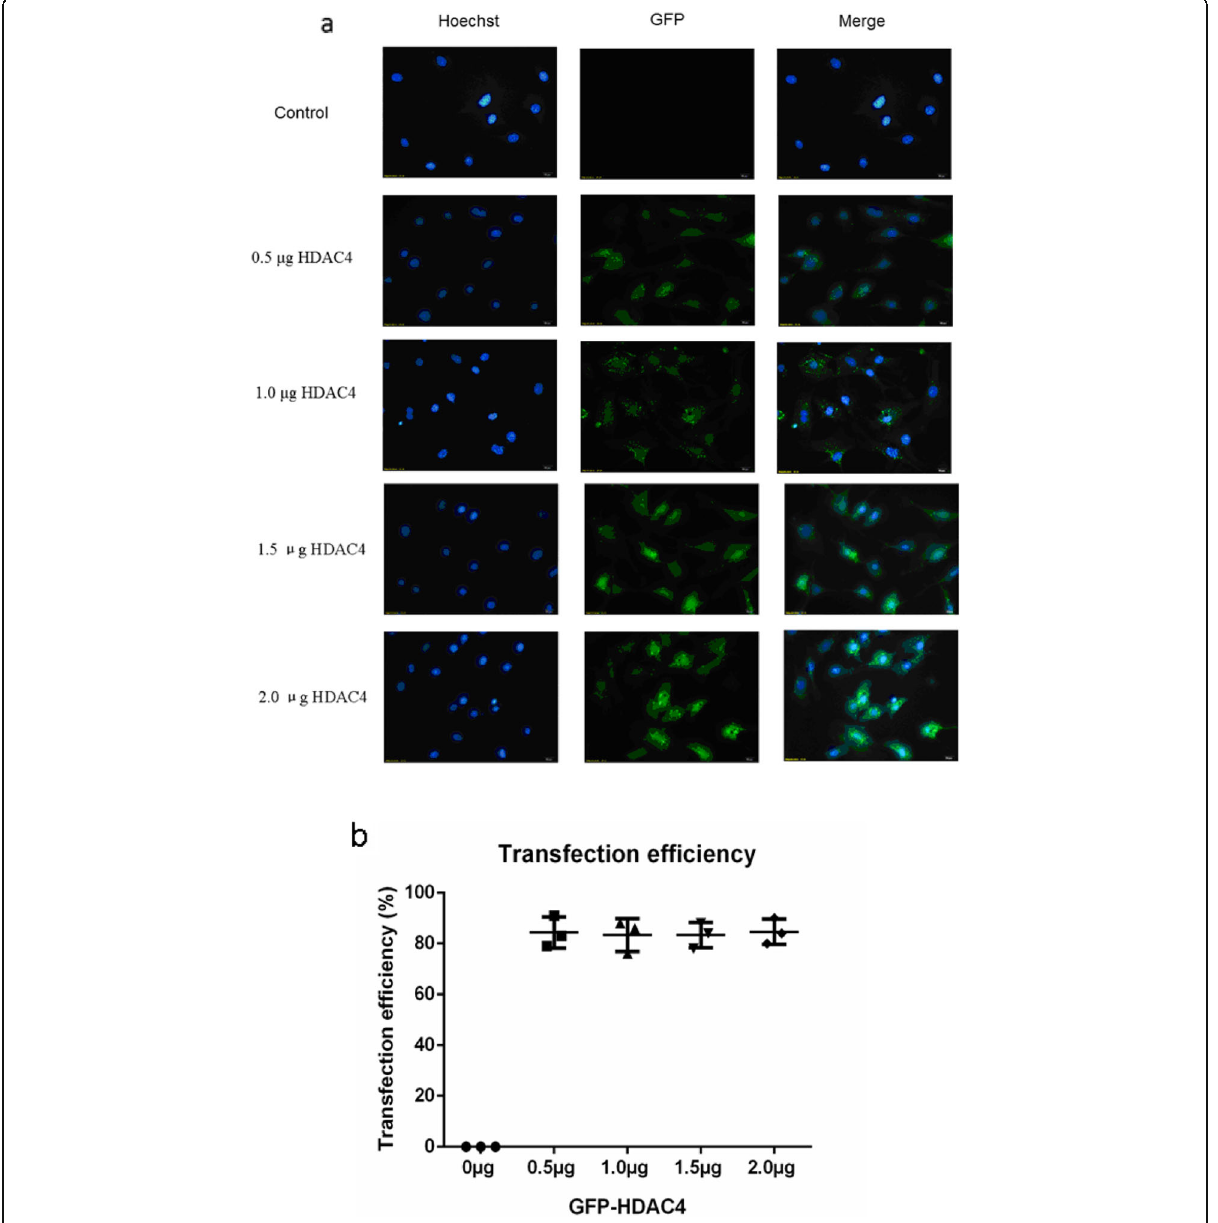
Fig. 4 Transfection efficiency of HDAC4 into isolated chondrocytes. a The transfection efficiency of various doses of GFP-HDAC4 DNA into isolated murine chondrocytes was examined with confocal laser scanning microscopy based on GFP expression. Nuclei are stained with Hoechst 33342 (Hoechst). b Approximately 300 cells from three independent experiments were scored. Data are expressed as mean ±